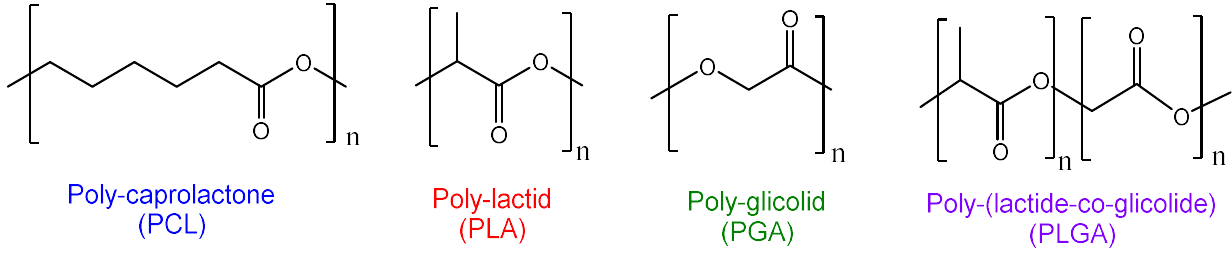
Figure 3. Chemical structures of the most widely used polymers for DDS generation. PCL is used for DDS generation in the form of copolymers with other low degradation rate polymers; PLA is an ideal environment for the generation of polymeric NPs capable of encapsulating hydrophobic therapeutics; PGA is mainly used in tissue engineering; PGLA is by far the most used for DDS generation due to the easy hydrophobic/hydrophilic ratio modulation.